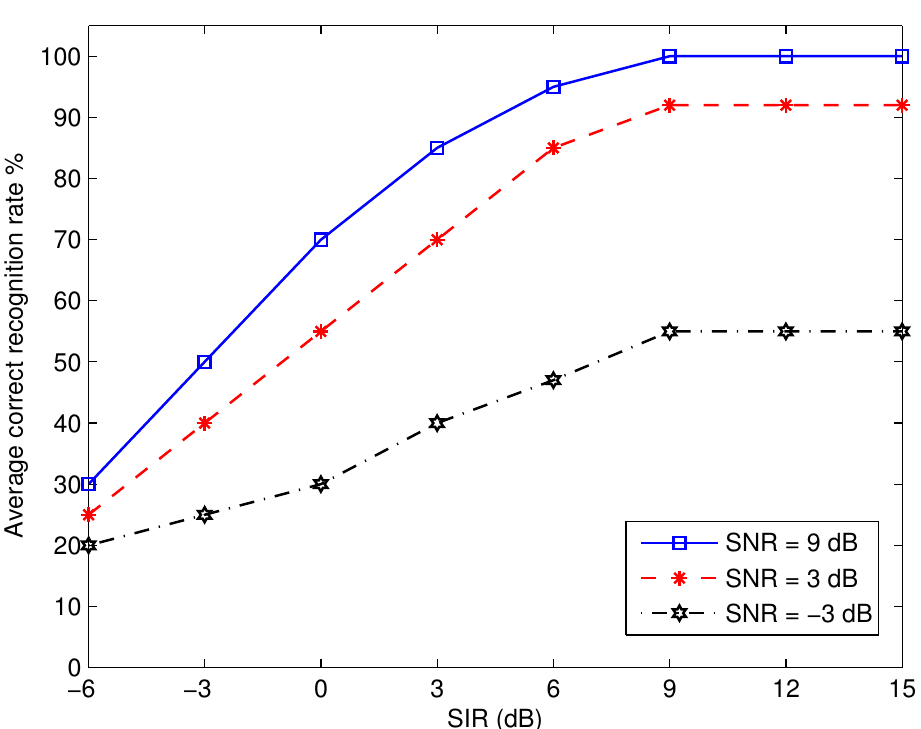
Figure 10. Performance of the proposed algorithm in the presence of narrow-band interference. Table 4. Confusion matrix of the proposed algorithm at SNR = 12 dB and σ 2